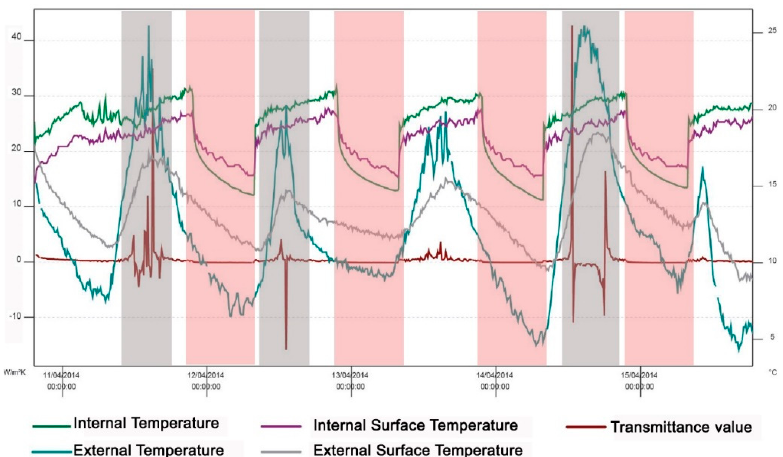
Figure 4. Part of the data detected by the thermal flux meter. Graphical output. Some anomalous peaks of the transmittance value were highlighted with the grey background. These peaks occurred because in the days of the measurements, the internal-external difference of temperature around noon, was not at least 10–15 degrees. Instead four moments at night were highlighted in pink. During these moments, the heating system was turned off because the internal temperature was close to 20 degrees and the wall collected heat because of the inertial effect. As time passed, the internal temperature decreased and the wall started to loss heat.